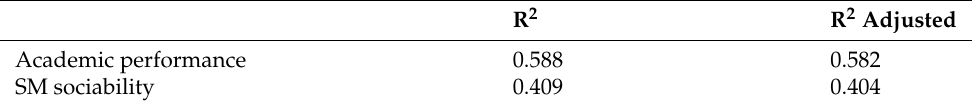
Table 6. R 2 coefficients of determination.